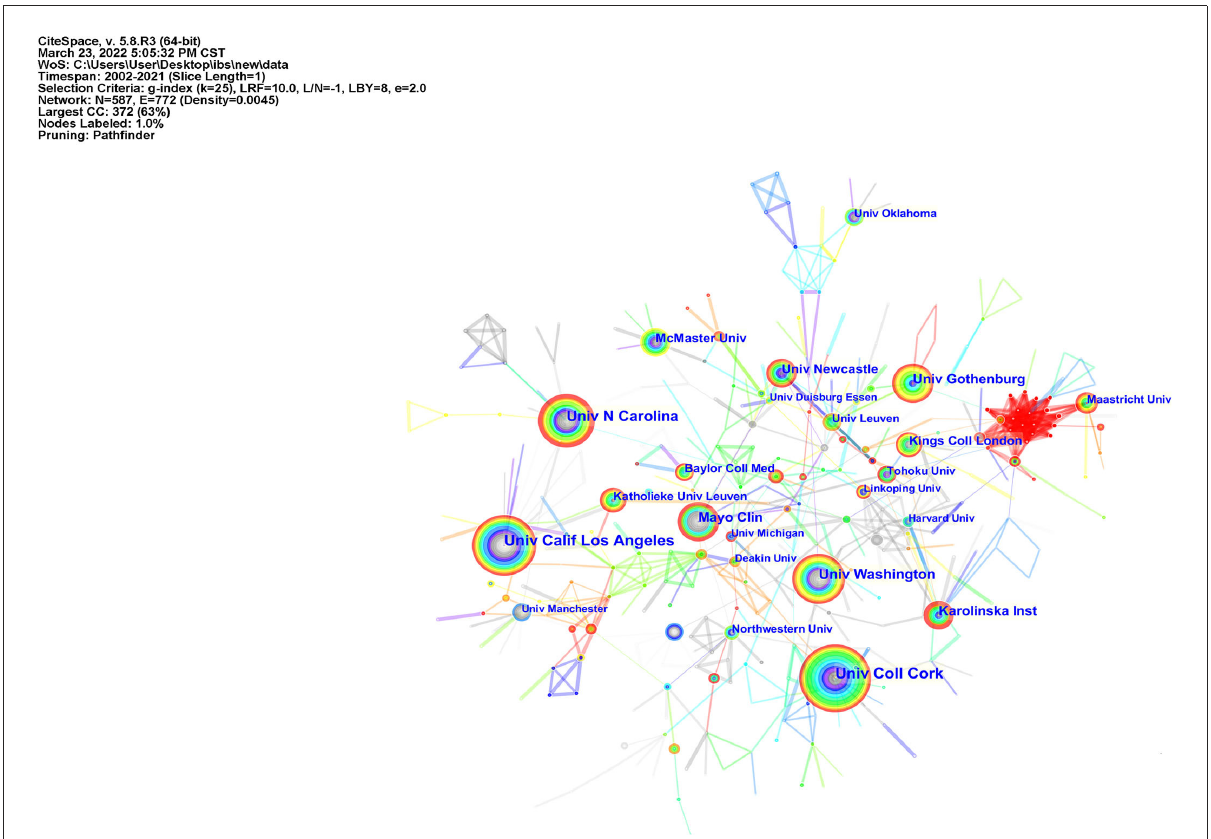
FIGURE3 Collaboration network of institutions in IBS research related to anxiety or